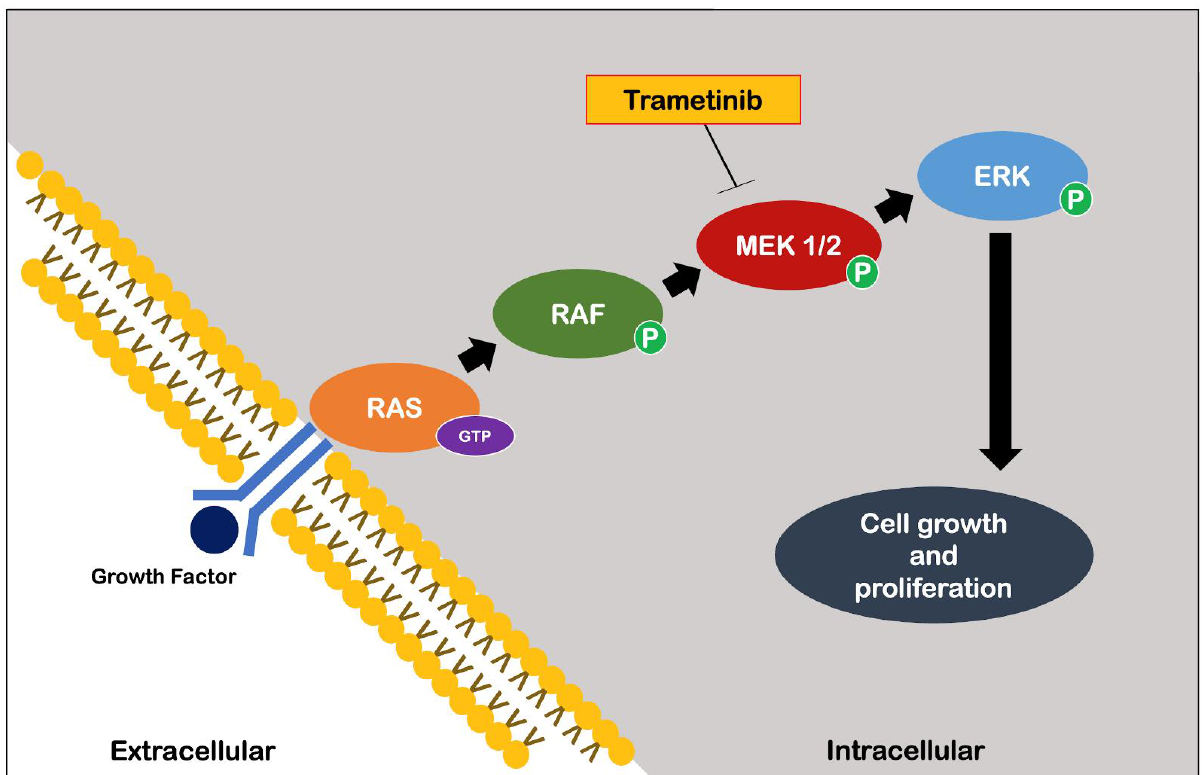
Figure 5. Trametinib action (adapted from Khunger et al. [46]). Arrows in black represent the stimulatory action of molecular elements. Abbreviations: ERK, extracellular signal-regulated kinase; GTP, guanosine triphosphate; MEK, mitogen-activated protein kinase; P, phosphorus; RAF, kinase; RAS, GTPase.